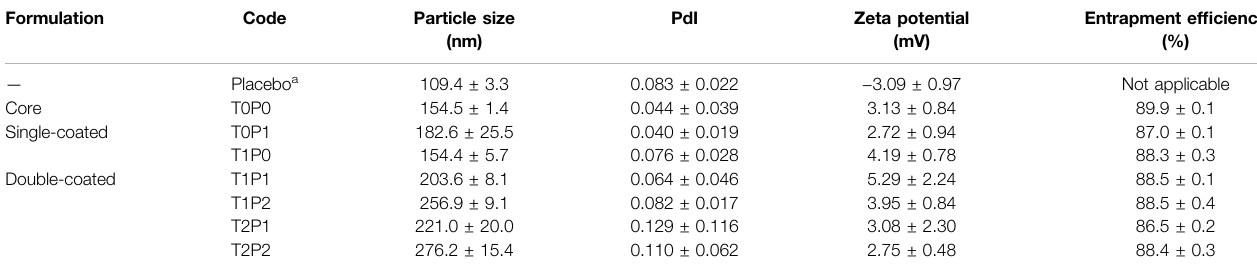
TABLE 1 | Formulation codes and characteristics of various doxorubicin-loaded PBCA-NPs formulations (data present mean ± SD, n (cid:1) 3). Formulation